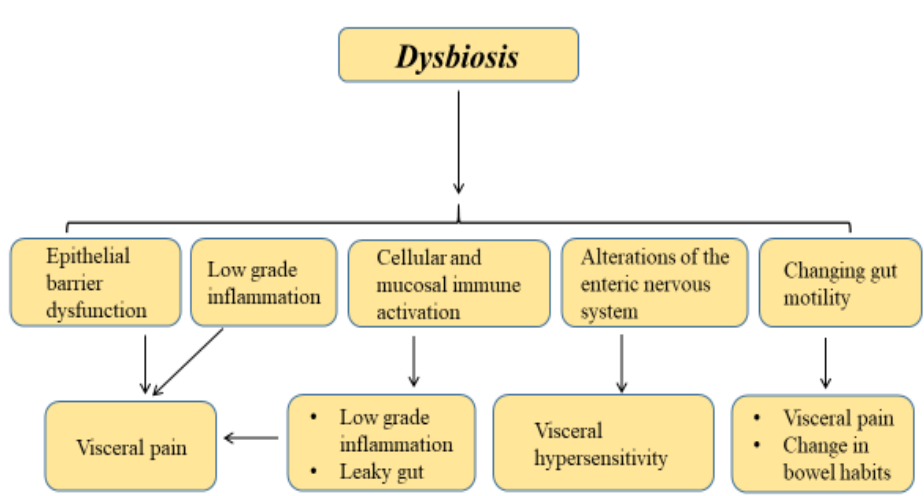
Figure 1. Role of the microbiome in irritable bowel syndrome (IBS).